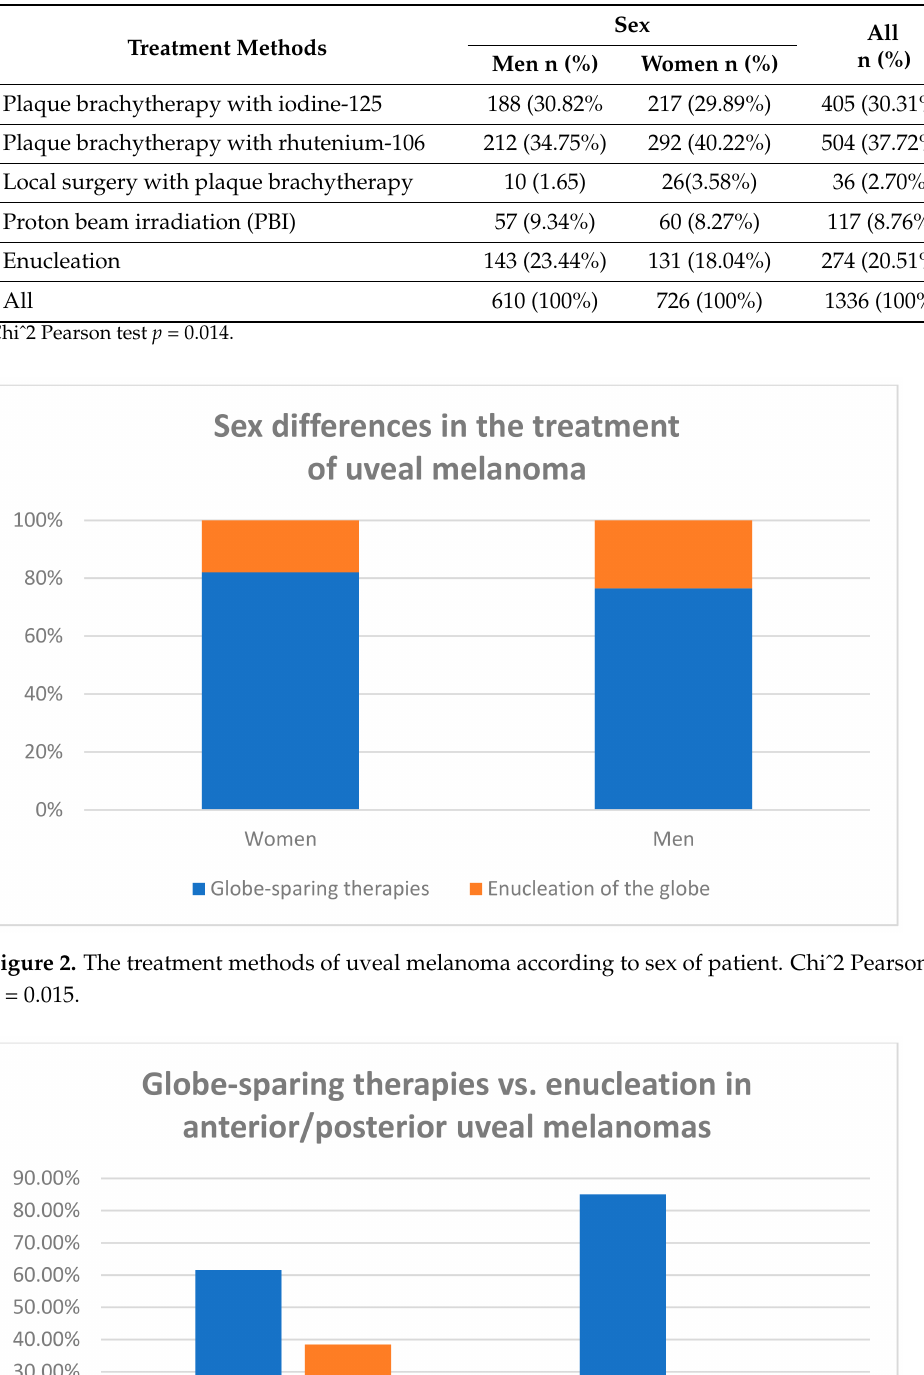
Table 4. The treatment methods of uveal melanoma according to sex of patient.